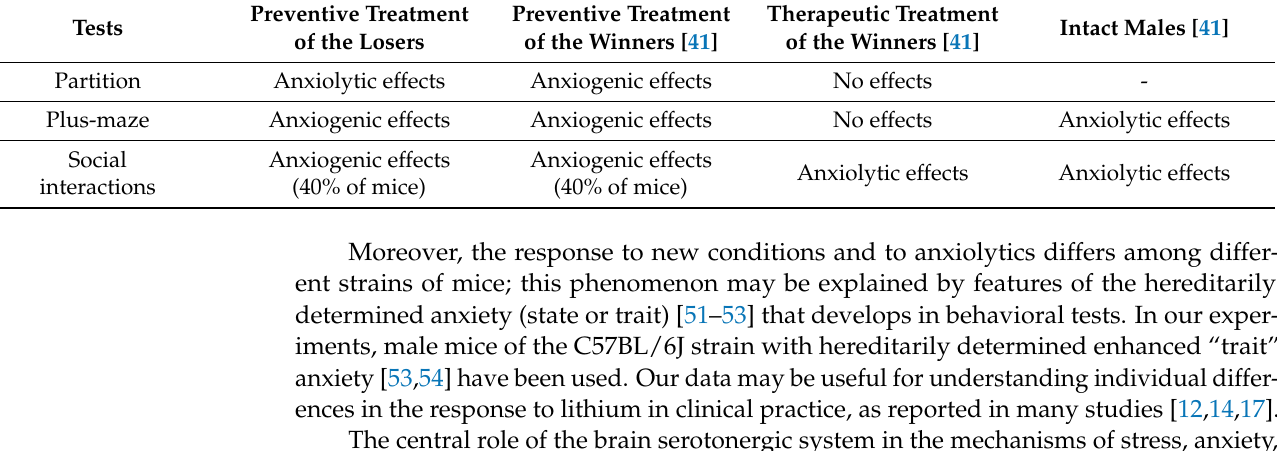
Table 1. Effects of chronic LiCl treatment on the anxiety-like behavior of mice with opposite social experiences.